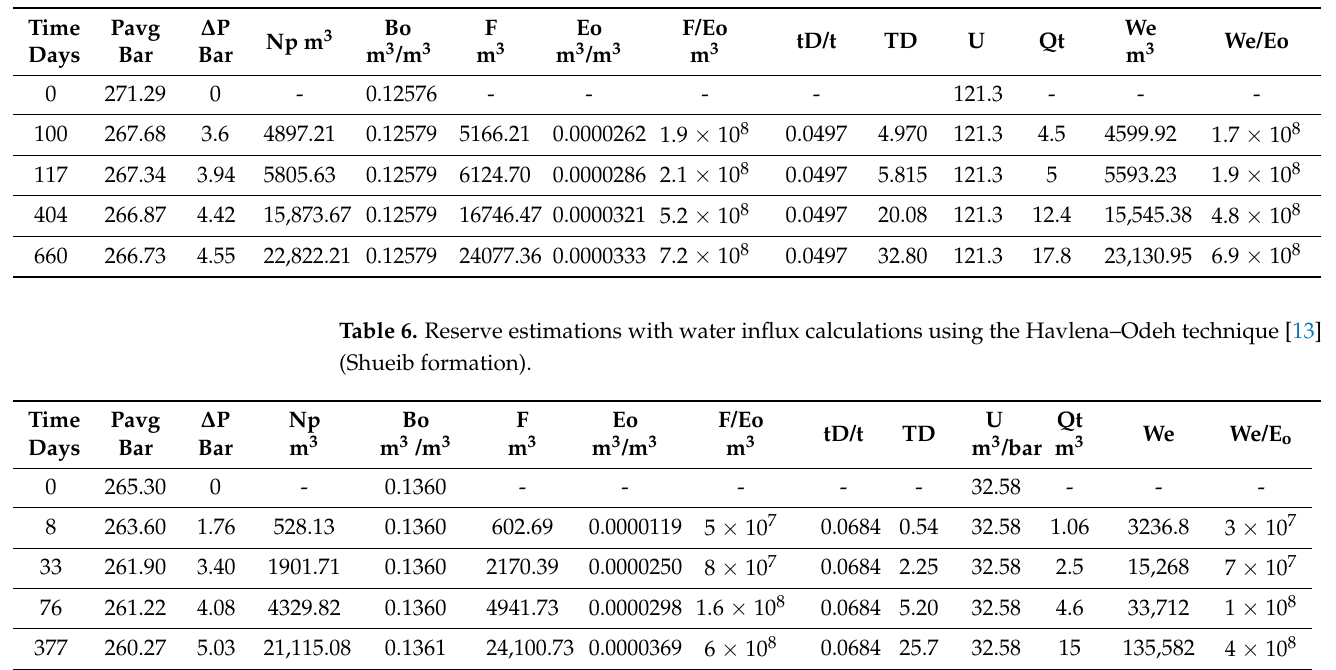
Table 5. Reserve estimation using water influx calculation for Hummar formation.